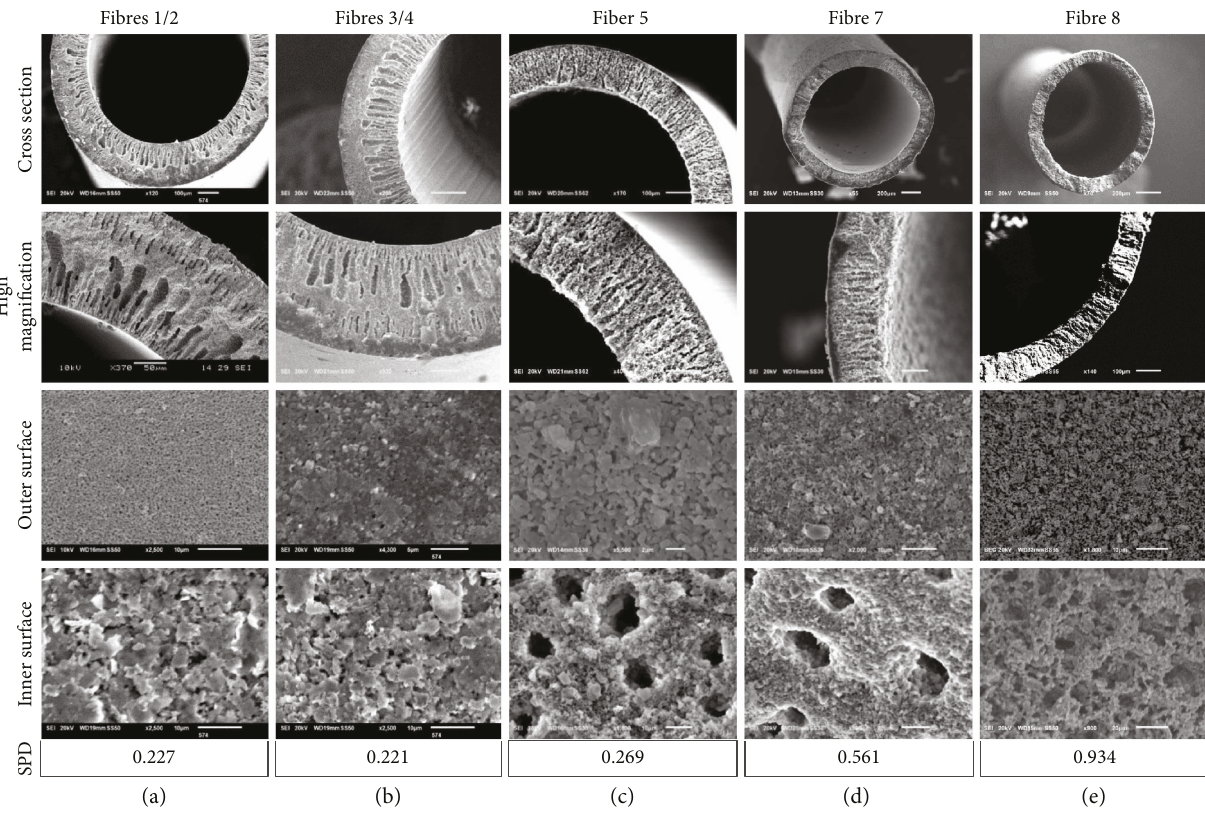
Figure 3: Representative SEM images and smallest pore diameter (SPD) of fabricated fi bres. (a) fi bres 1 and 2, (b) fi bres 3 and 4, (c) fi bre 5, (d) fi bre 7, and (e) fi bre 8. Fibres 1 and 5 were de fi ned as the “ water fi bre ” and “ DMSO fi bre ” , bre) enucleated cells in fi ltrate suspension. Flow cytometry con fi rmed enucleated CD235a + RBCs were separated from MNCs in cross- fl ow fi ltration (Supplementary Figure 1, Table 2).